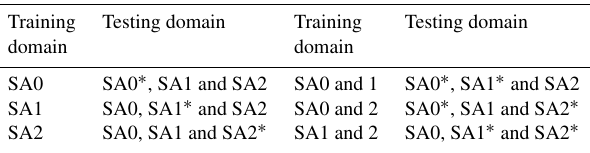
Table 1. Examined training data combinations to train the data- driven